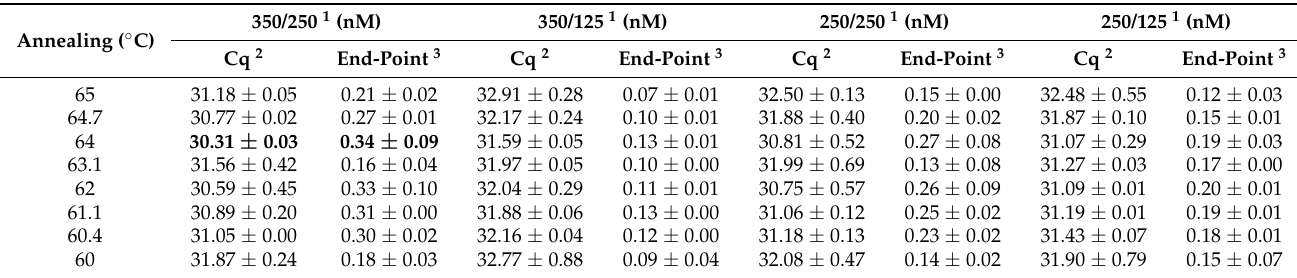
Table 2. Cq (quantification cycle) and end-point values ± their standard deviation at different annealing temperatures and primers/probe